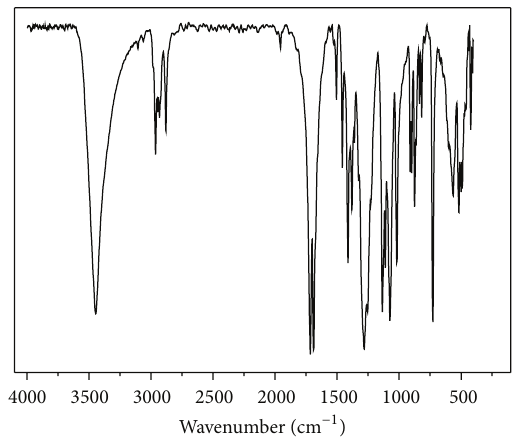
Figure 1: FT-IR spectra of main product of